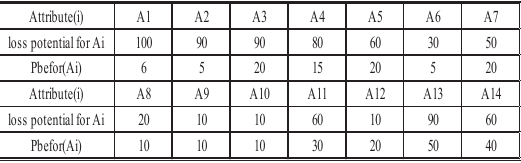
Table 1: Attributes And Their Loss Potential And Probability (Before